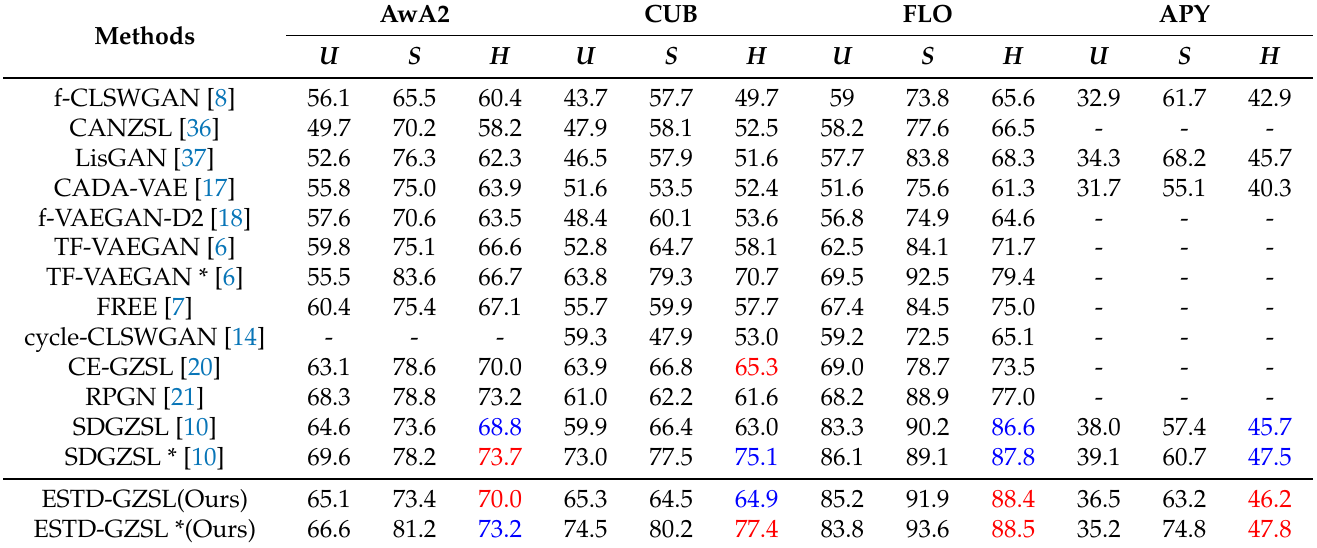
Table 2. Performance comparison in accuracy(%) on four datasets. We show the accuracies of seen and unseen classes and their harmonic mean for GZSL, which are denoted as U, S, and H. * means a finetuned backbone is used. Red font and blue font denote the highest and the second highest results,